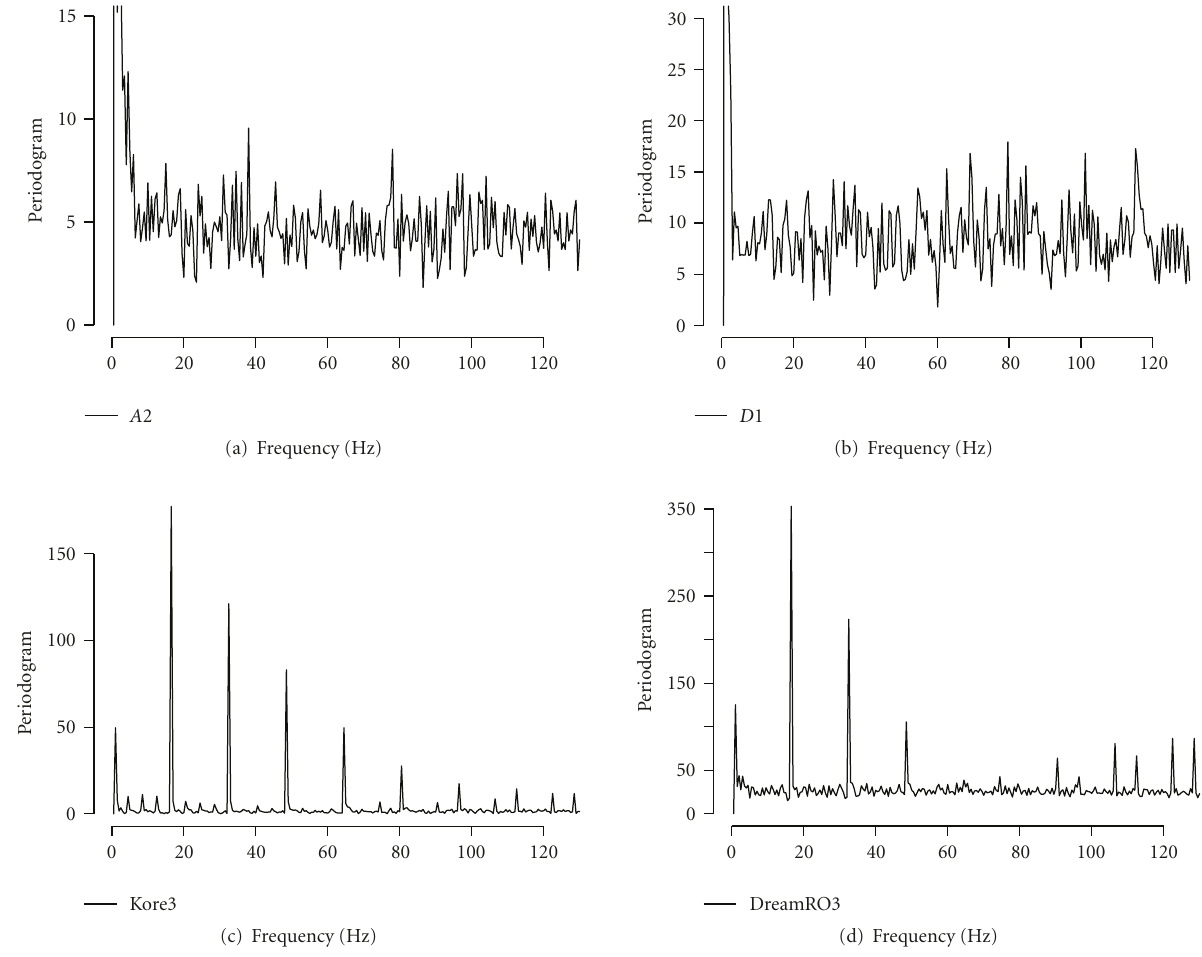
Figure 13: Periodograms of corresponding histograms (of client response times) in Figure 8. Note strong frequency components exist in bot